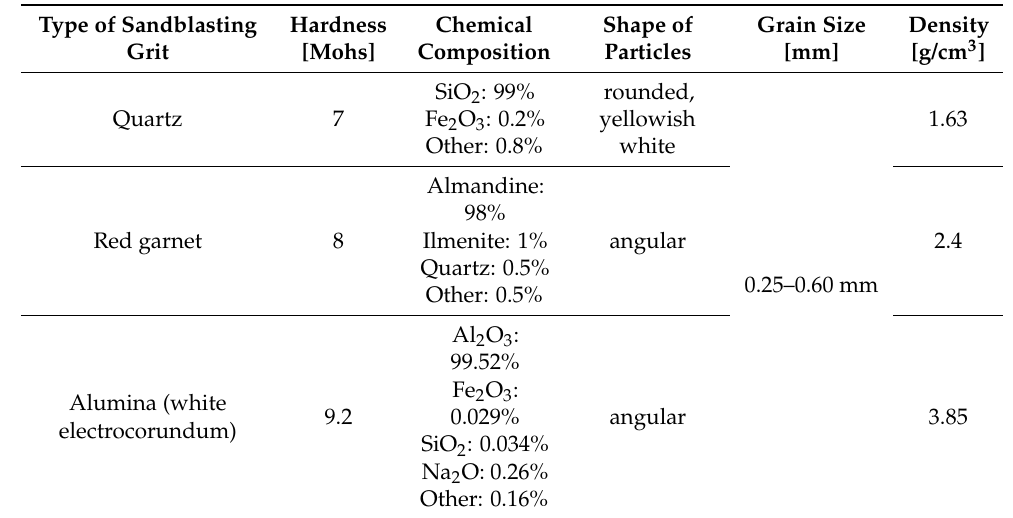
Table 2. Technical data of sandblasting